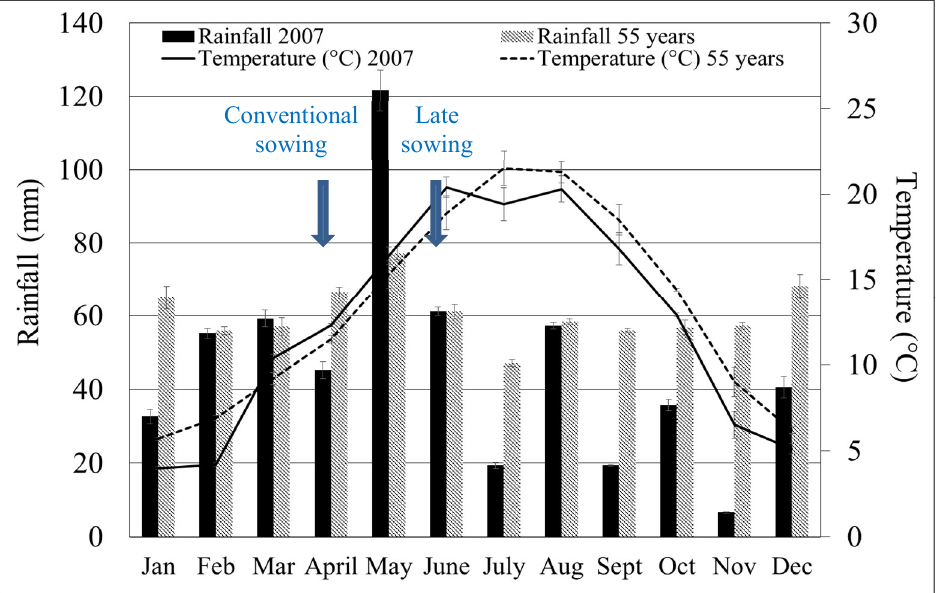
Figure 1. Mean monthly temperatures and rainfall during the cropping season of 2007 and average of 55 years in Auch (South West of France).